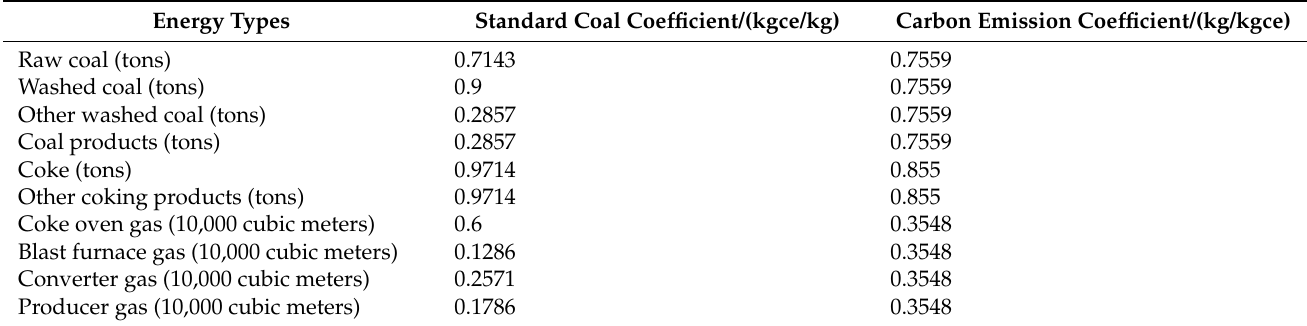
Table 1. Calculation parameters of carbon